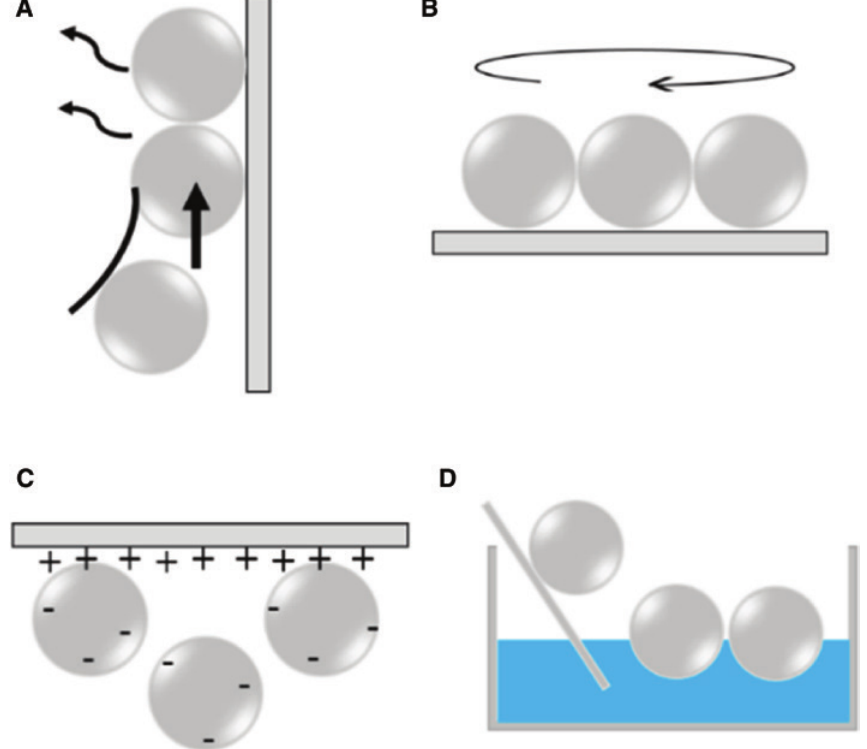
Figure 2: Various self-assembly strategies to fabricate ordered colloid arrays: (A) dip-coating [63], (B) spin-coating [64], (C) electrophoretic deposition of colloids [65, 66], (D) self-assembly at air/water interface [67,